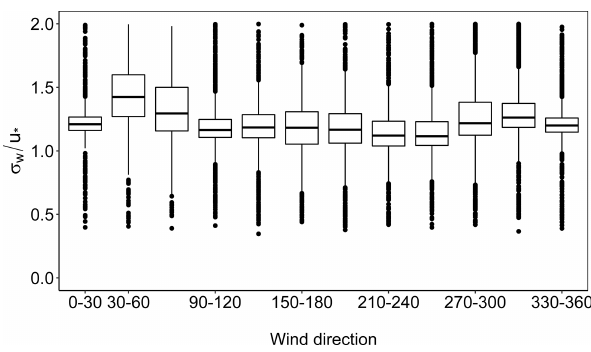
Figure 6. Box plots of the normalized SD of the vertical wind ve- locity ( σ w /u ∗ ) for the individual wind direction